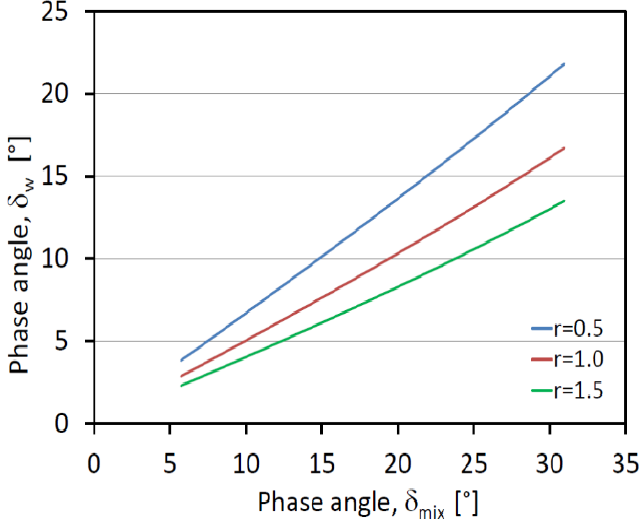
Figure 2. Model of the effect of the fraction with only in-phase response (having positive K ip ) on the whole rock phase angle. δ w is the whole rock phase angle, δ mix is the phase angle of the fraction with non-zero opMS, r= K ip /K ′ mix . Adapted from [9].